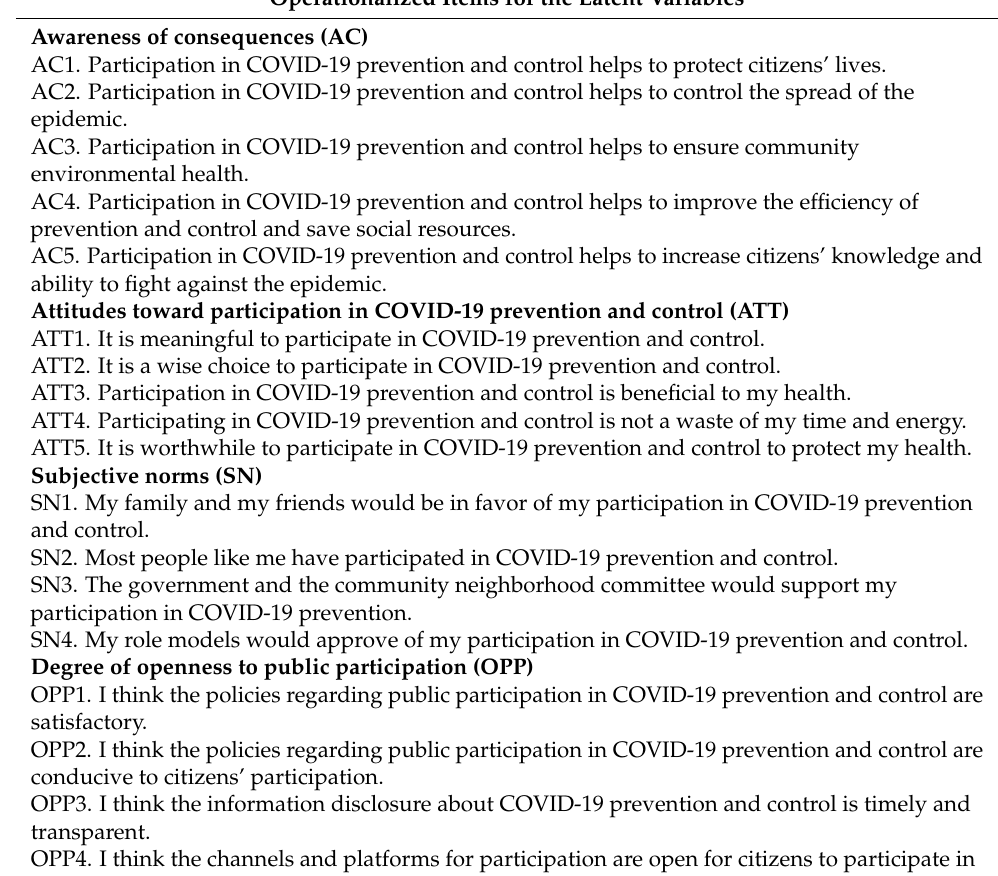
Table 2. Operationalized items for the latent variables. Operationalized Items for the Latent